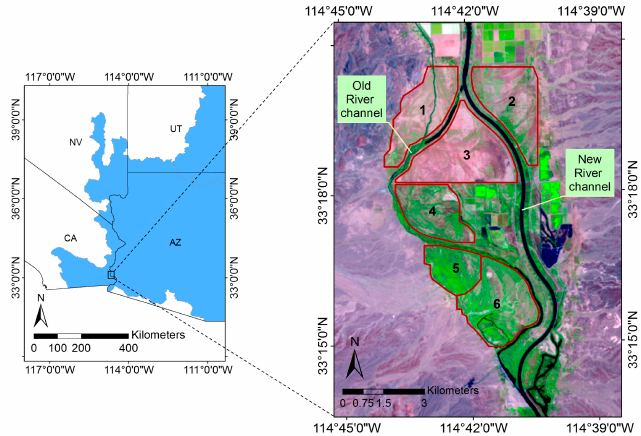
Figure 1. Location of the study area in the Lower Colorado River Basin ( left ). The six subareas in the right panel indicate parts of the Cibola National Wildlife Refuge (CNWR) included in this study.